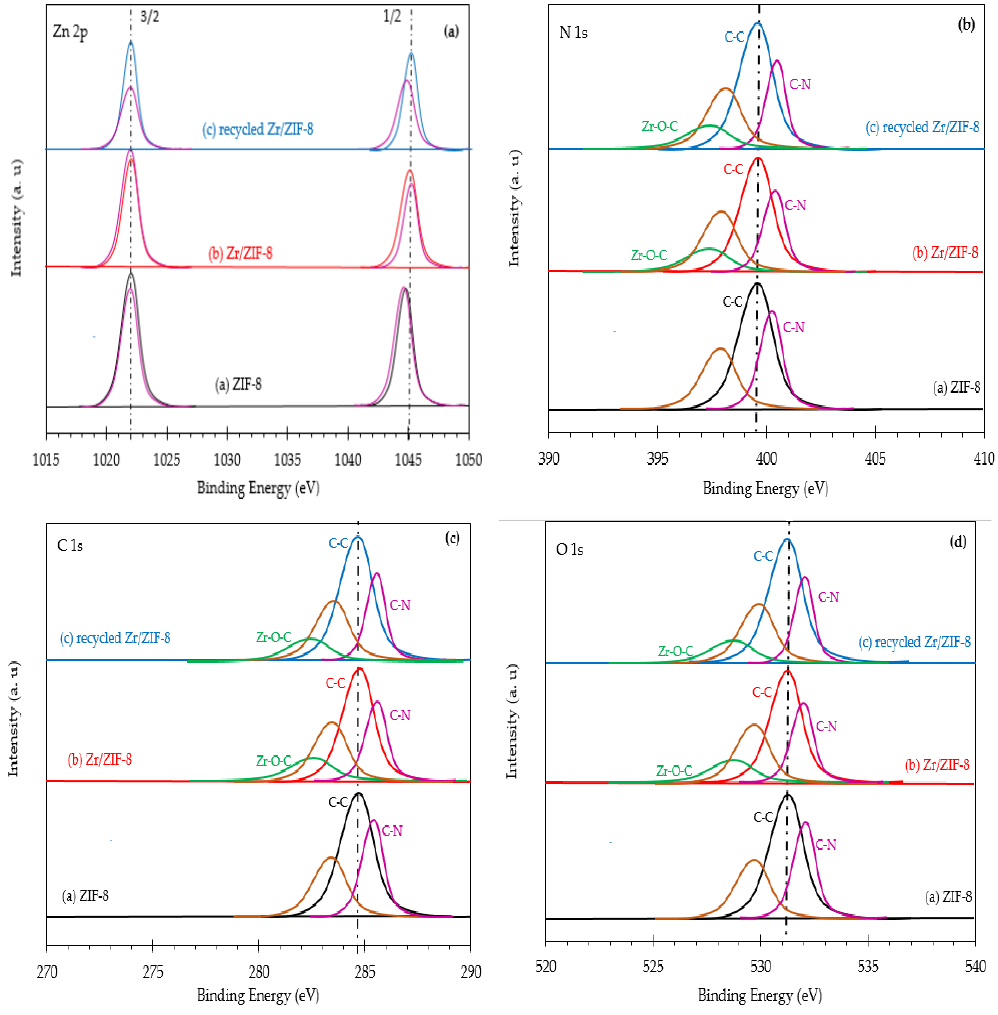
Figure 9. X-ray photoelectron spectroscopy (XPS) spectra showing deconvoluted regions of ZIF-8, Zr/ZIF-8 catalyst, and recycled Zr/ZIF-8 catalysts. ( a ) Zn 2p, ( b ) N 1s, ( c ) C 1s, ( d ) O 1s.